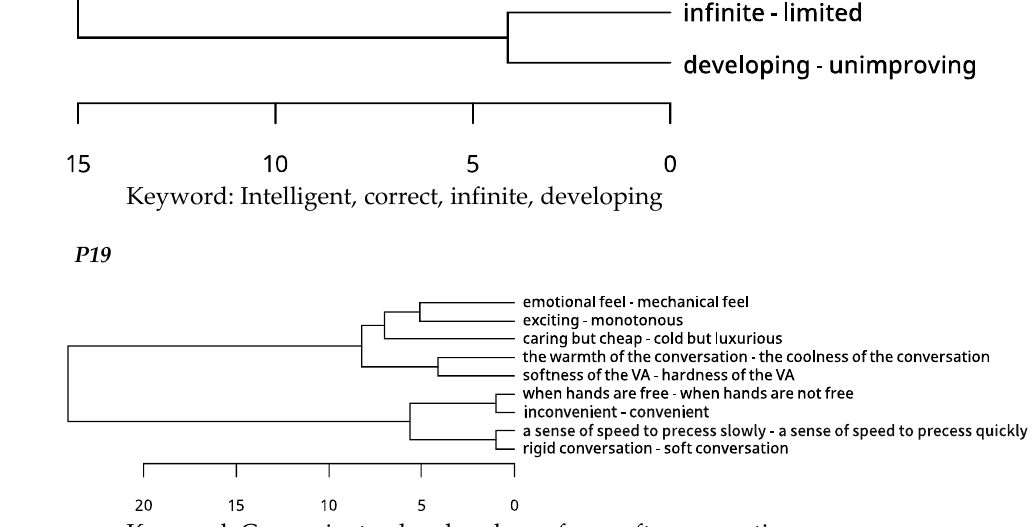
Figure A1. HCA data of Repertory Grid.